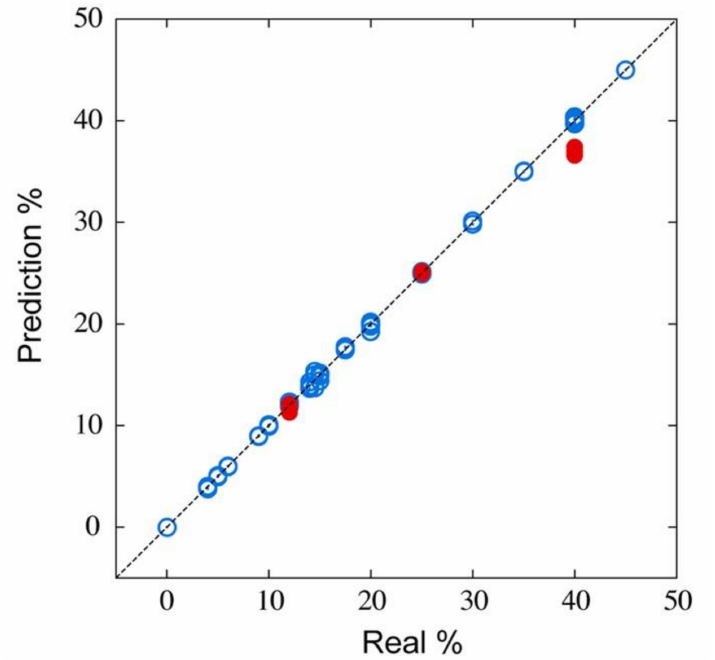
Figure 17. Parity plot of predicted alcohol content versus real alcohol content under an ambient condition. The blue open circles represent the known liquors which are used to train the machine learning model. The red solid circles are the unknown liquors: red wine (12%), Imo-shochu (25%), and whisky (40%). Reprinted from Ref. [8], the author licensed under CC-BY